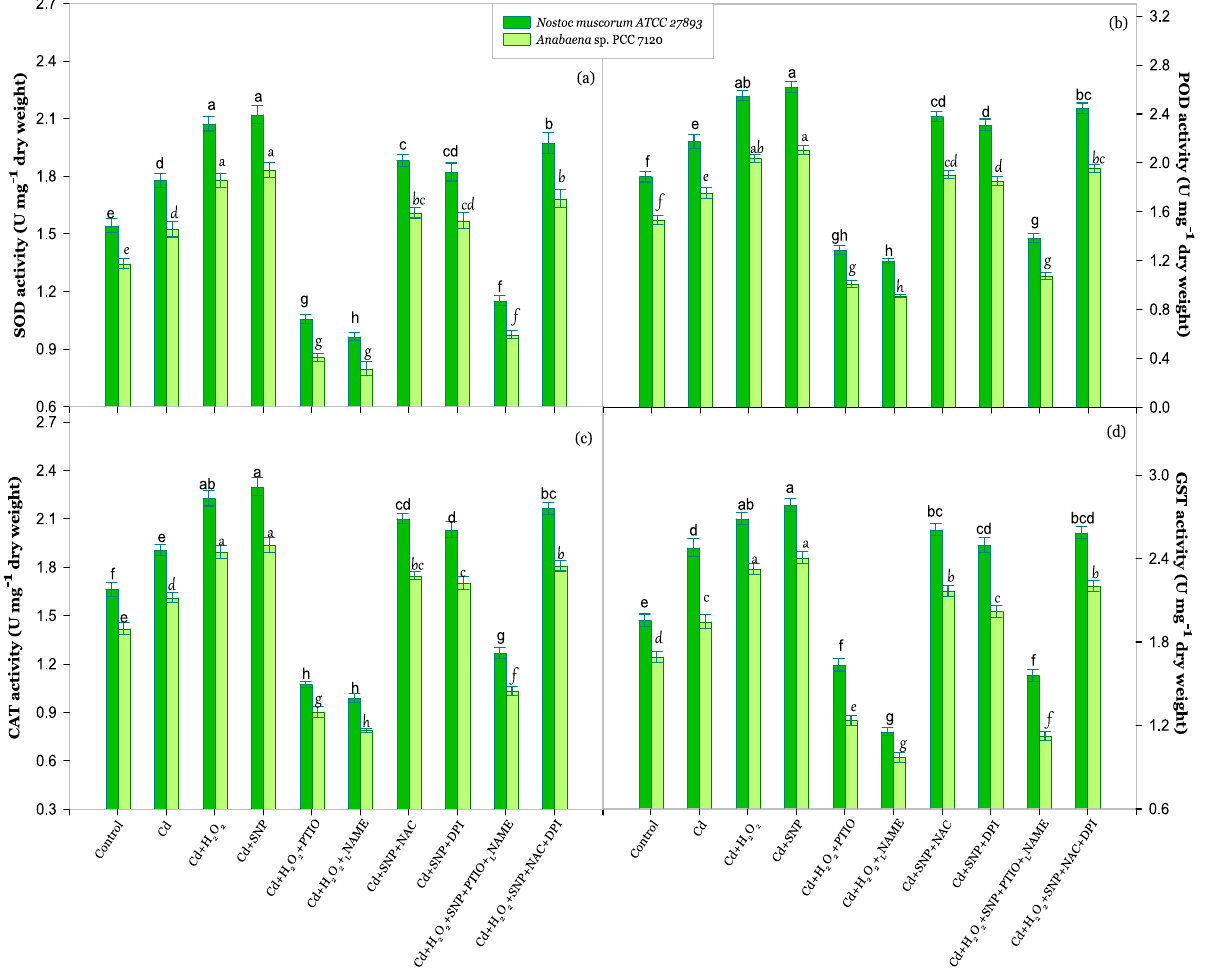
Figure 5. Effect of H 2 O 2 and NO (SNP) on the activity of enzymatic antioxidants; SOD (a) , POD (b) , CAT (c) and GST (d) of Nostoc muscorum ATCC 27893 and Anabaena sp. PCC 7120 exposed to Cd after 24 h of treatment. Data presented are means ± standard error of three independent experiments with three replicates in each experiment (n = 9). Bars with different letters represent significant difference at P < 0.05 significance level according to the